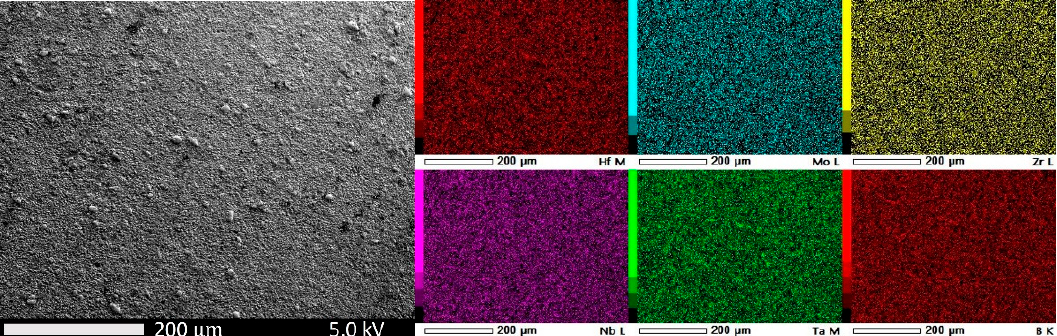
Figure 5. SEM and EDS analysis of high-pressure, high-temperature synthesized (Hf, Mo, Nb, Ta, Zr)B 2 sample. The EDS analysis based on X-ray fluorescence shows the distribution of the five transition metals and boron in the high entropy boride sample.